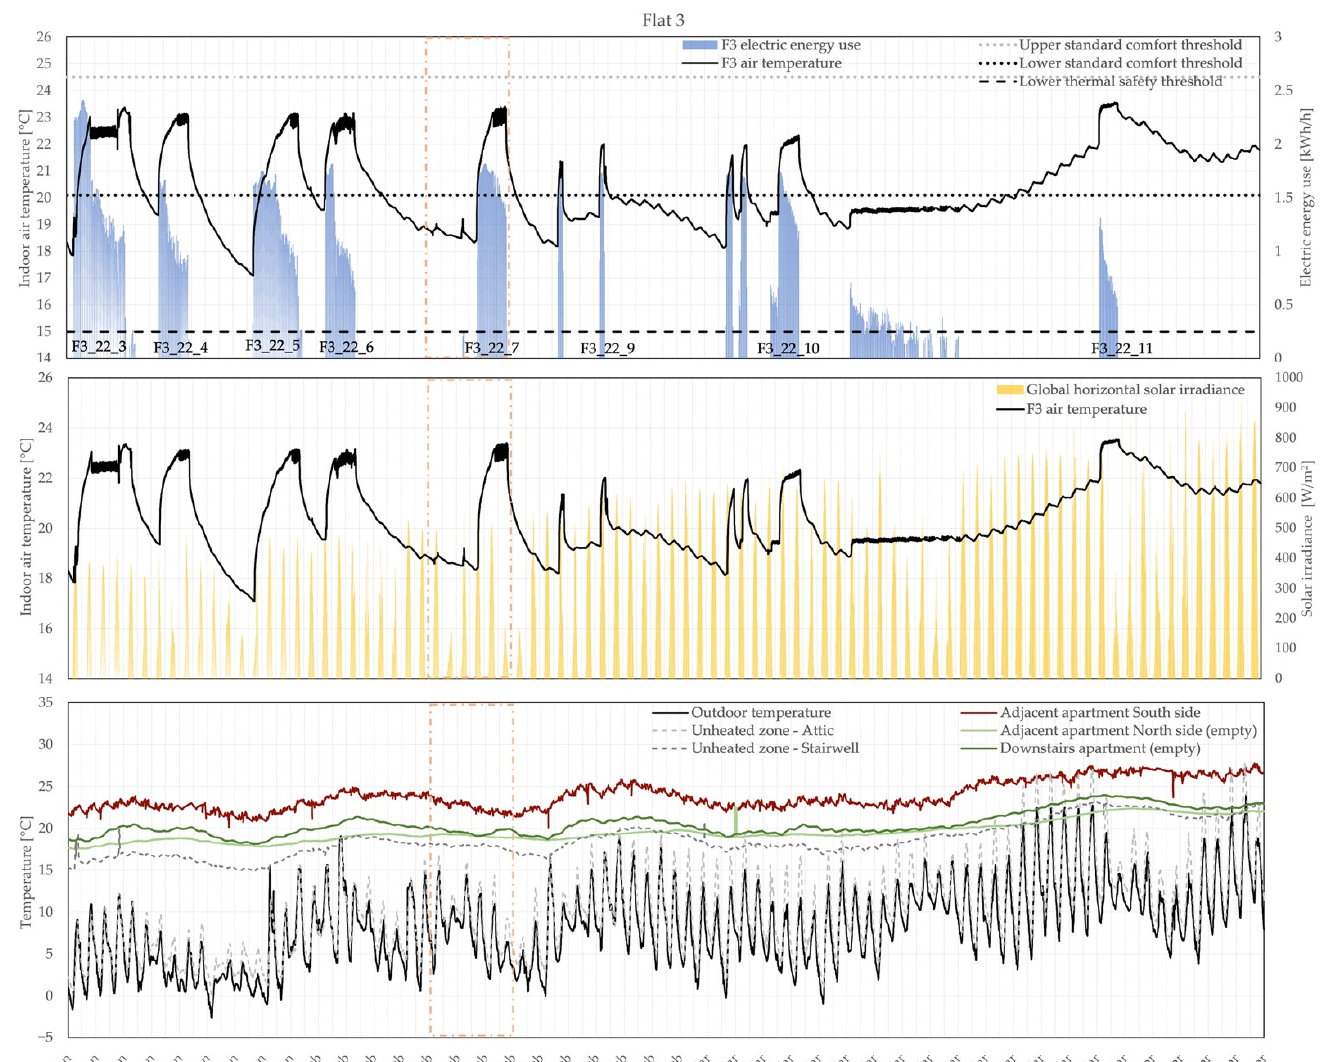
Figure 10. Representation of the indoor air temperature variation in the flat F3, located at the third floor and north-oriented during the tests performed from 14 January 2022 to 9 April 2022. The energy interruption occurred from 9 to 15 February in the entire building and is highlighted with orange, dashed lines.